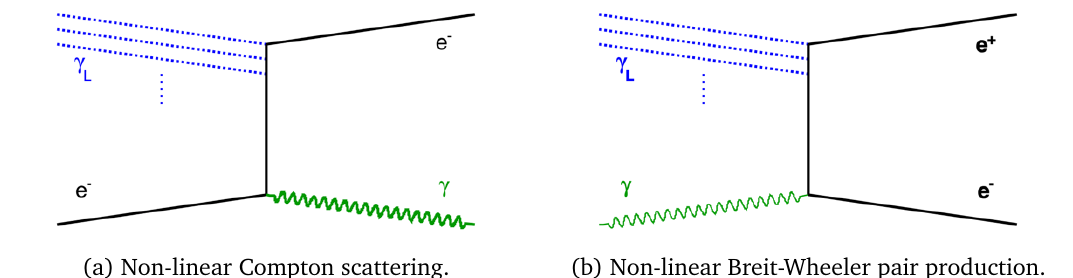
Figure 1: Feynman diagrams of strong-field QED processes at LUXE [ 8 ]